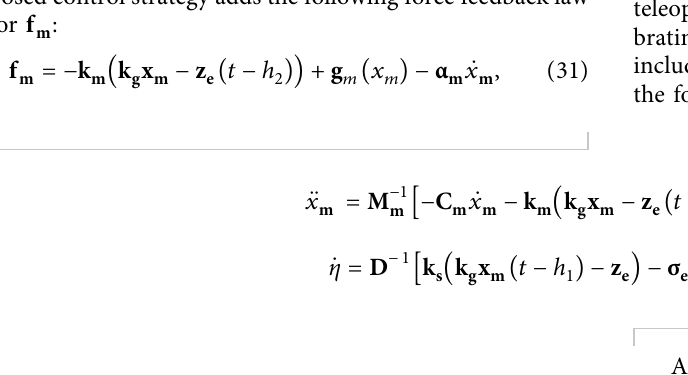
Figure 6: Stability surfaces, is visualized as the real damping and walking cycle time change, taking diferent Δ p : (a) Δ p � 0 . 5, and (c) Δ p � 0 . (b) Δ p v v hip hip